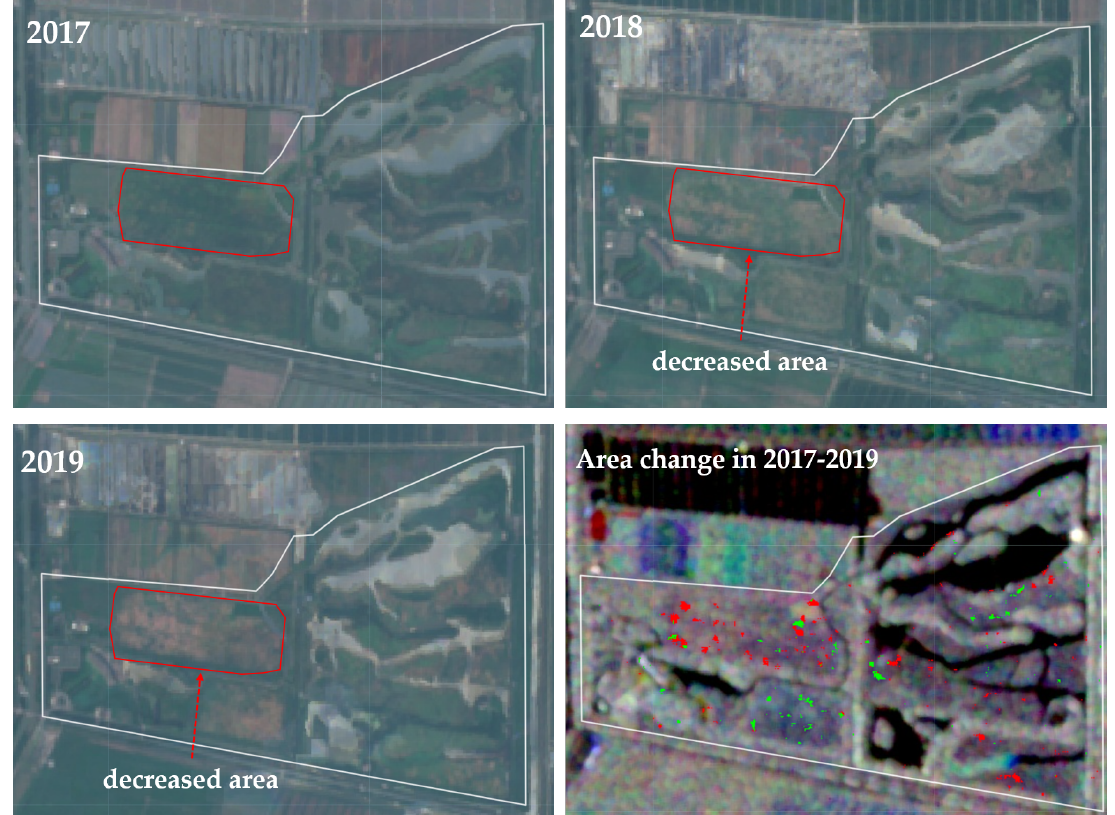
Figure 12. One of the subjective evaluations of the credibility of the fine forest change methods proposed in this paper. Optical images collected by Sentinel 2 have the same spatial resolution with SAR